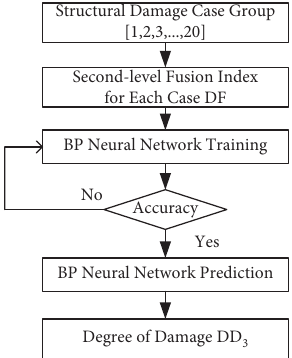
Figure 6: Third-level fusion method based on BP neural